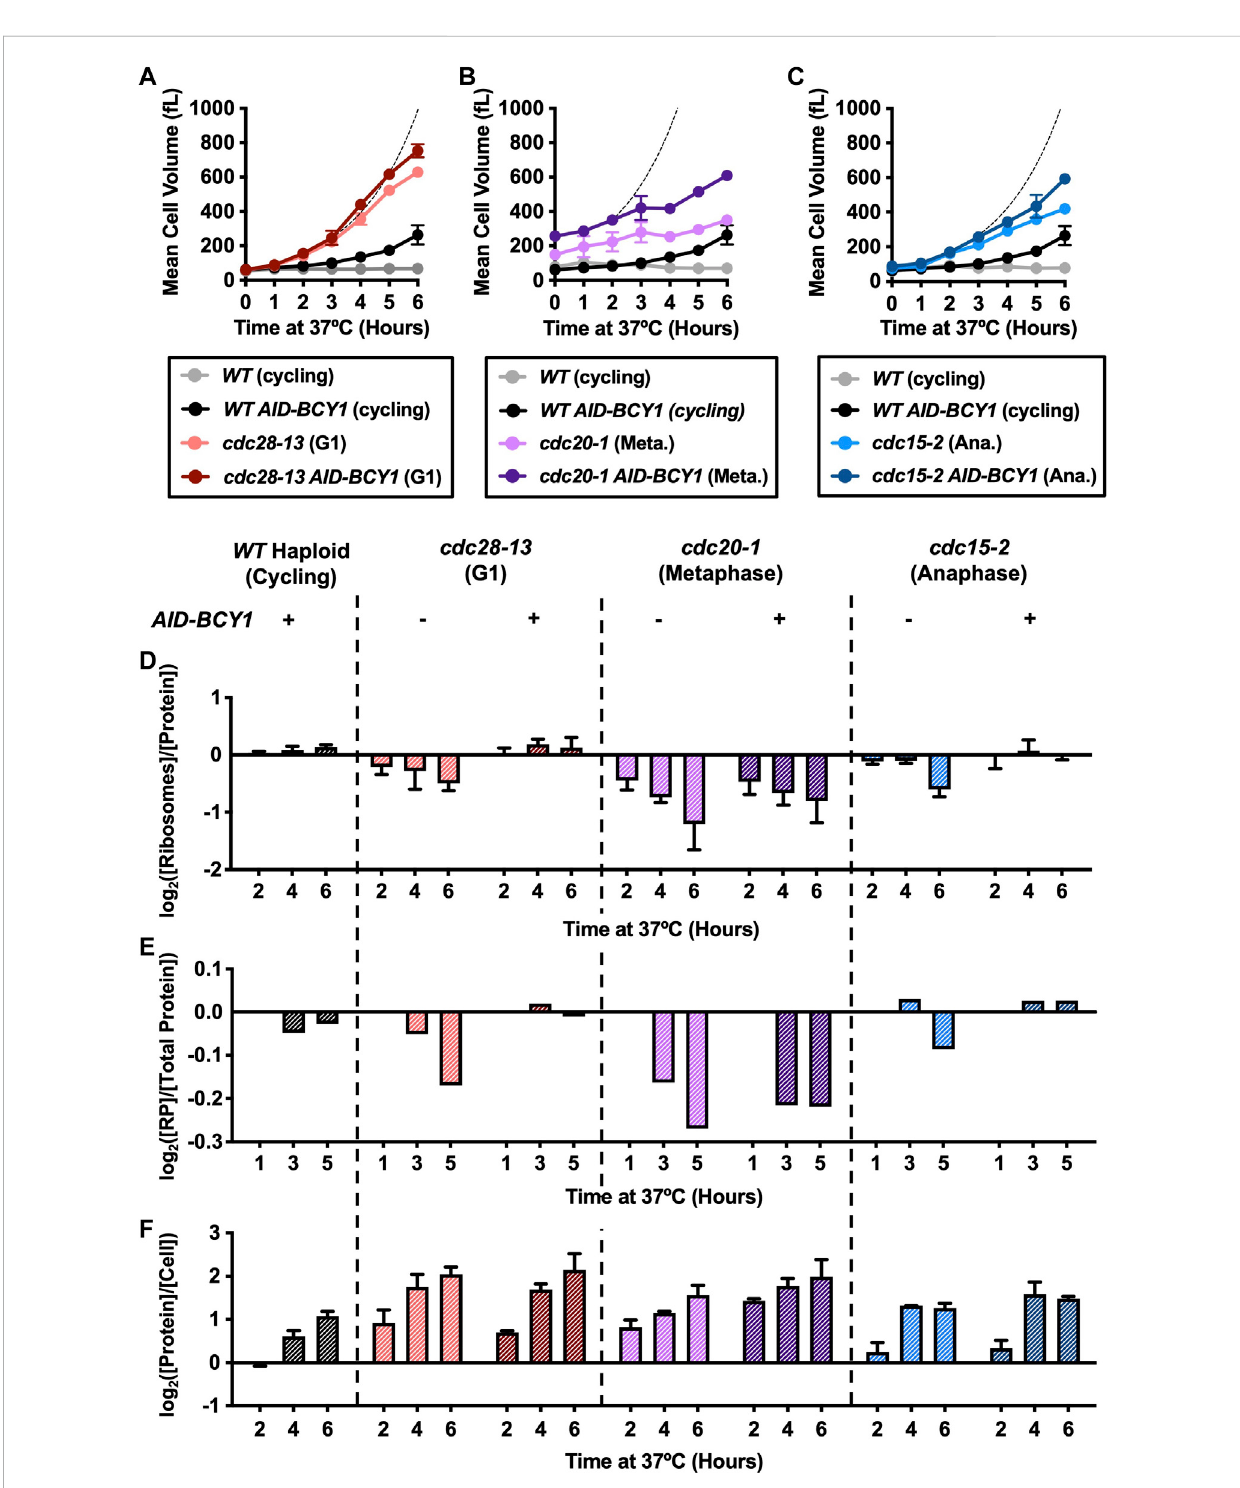
FIGURE 5 Hyperactivation of the Ras/PKA pathway attenuates ribosome depletion during cell cycle arrest. WT (A2587), WT AID-BCY1 (A40439), cdc28-13 (A39000), cdc28-13AID-BCY1 (A40444), cdc20-1 (A937), cdc20-1AID-BCY1 (A40499), cdc15-2 (A2596),and cdc15-2AID-BCY1 (A40501)cellsweregrown tologphaseinYEPD(supplementedwith138 μ Lglacialaceticacidforeach1 LYEPD)at25 ° Candthenshiftedto37 ° Cfor9 h. WT and WTAID-BCY1 (cycling) cultureswerekeptatanOD 600nm between0.2 – 0.8,bydilutingwithpre-warmed(37 ° C)YEPD(supplementedglacialaceticacid).TheauxinanalogueIAA (500 μ M)wasaddedafter2 hand4 hat37 ° C. (A – C) Meancellvolume(fL)wasmeasuredonacoultercounterfortheindicatedgenotype.ThesameWTAID- BCY1 data is shown in A-C for comparison. The dashed line indicates theoretical exponential volume growth after BCY1 depletion (90-min doubling time). Errorbarsrepresentrangeoftwoexperimentalreplicates. (D) Proteinandintactribosomeconcentrationswerequanti fi edasdescribedinthemethodsection and[Ribosome]/[Protein]wasdetermined.ValueswerenormalizedtothoseoftheWTcyclingsamplesateachtimepointandsubsequentlylog 2 transformed. Errorbarsrepresentrangeoftwoexperimentalreplicates. (E) TMTProteomicswasperformedasdescribedinthemethods.Thefractionofribosomalproteins (RP) in total protein extracts ([RP]/[Total Protein]) was calculated. Values were normalized to the 1-h time point in each experiment and subsequently log 2